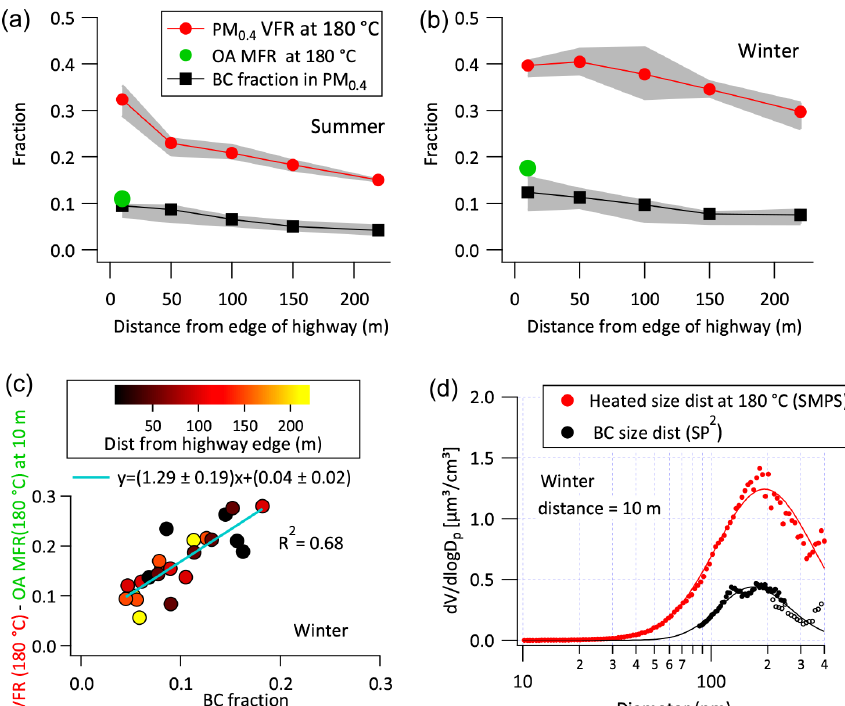
Figure 2. Campaign-average downwind evolution of volume fraction remaining (VFR) of PM 0 . 4 (integrated SMPS volume over 10–400nm) at 180 ◦ C in a TD (Rt = 30s) and black carbon (BC) fraction in PM 0 . 4 during (a) summer and (b) winter. Points are the mean and the shaded area represents the interquartile range. OA MFR was measured using a TD–ACSM system (Rt = 30s) only in the near-road trailer. (c) Correlation between the BC fraction and VFR of PM 0 . 4 (at 180 ◦ C) at various downwind distances after subtracting OA MFR (at 180 ◦ C) measured at 10m. (d) Comparison of SMPS-measured thermodenuded size distribution at 180 ◦ C and SP2-measured BC size distribution.